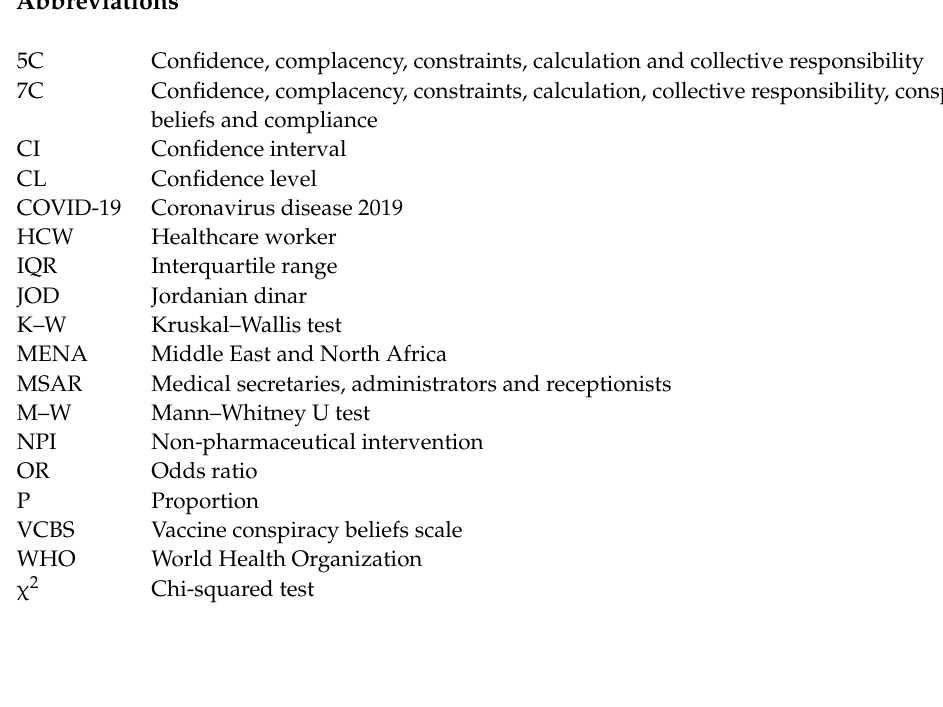
Supplementary Figure S1: Filtration algorithm used to exclude participants that did not meet the inclusion criteria and those with suspected careless